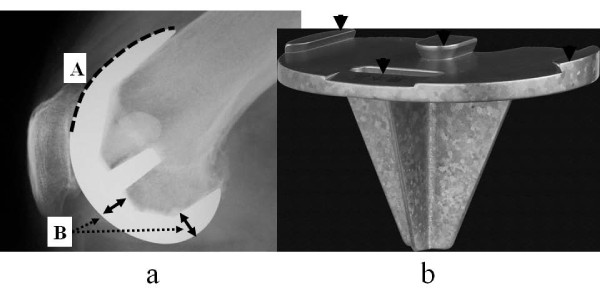
FNK femoral component and FNK tibial component. a: FNK femoral component. (A) The anterior chamber is thin to decrease pressure on the patellofemoral joint. (B) The standard size (size M) component is 7-mm thick at both the distal and posterior condyles, which is thinner than those in other Western company systems. b: FNK tibial component. The FNK tibial component has a 4-point locking mechanism (black arrows), a wide cross-shaped keel to soften the stress in various directions, and is 3.5 mm at the thinnest part to allow retention of original bone.